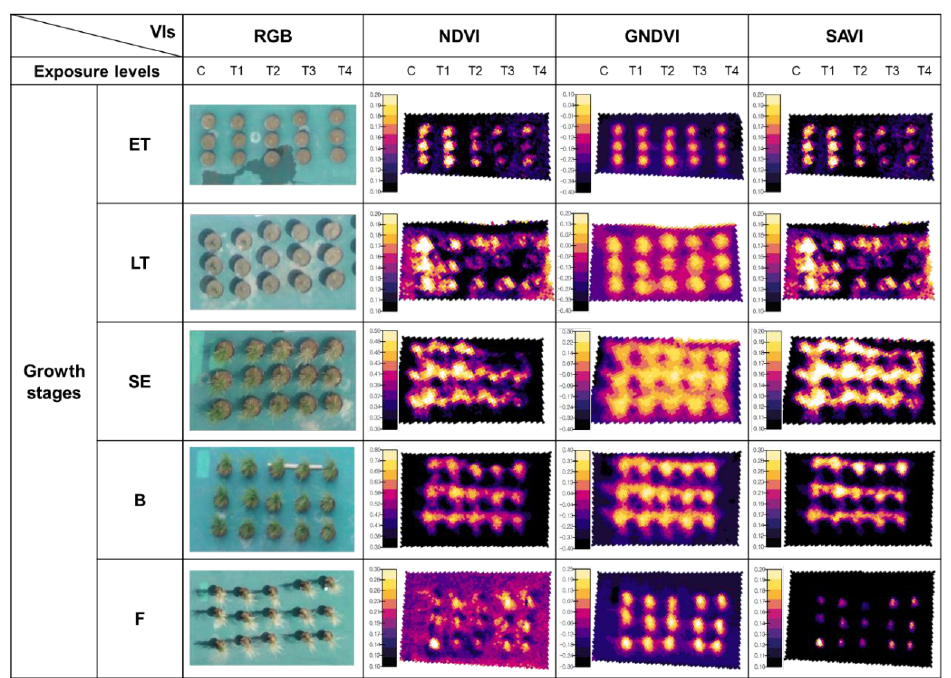
Figure 3. The orthomosaic RGB images, normalized difference vegetation index (NDVI) map, green NDVI (GNDVI) map, and soil-adjusted vegetation index (SAVI) map at five growth stages of toluene exposed rice.